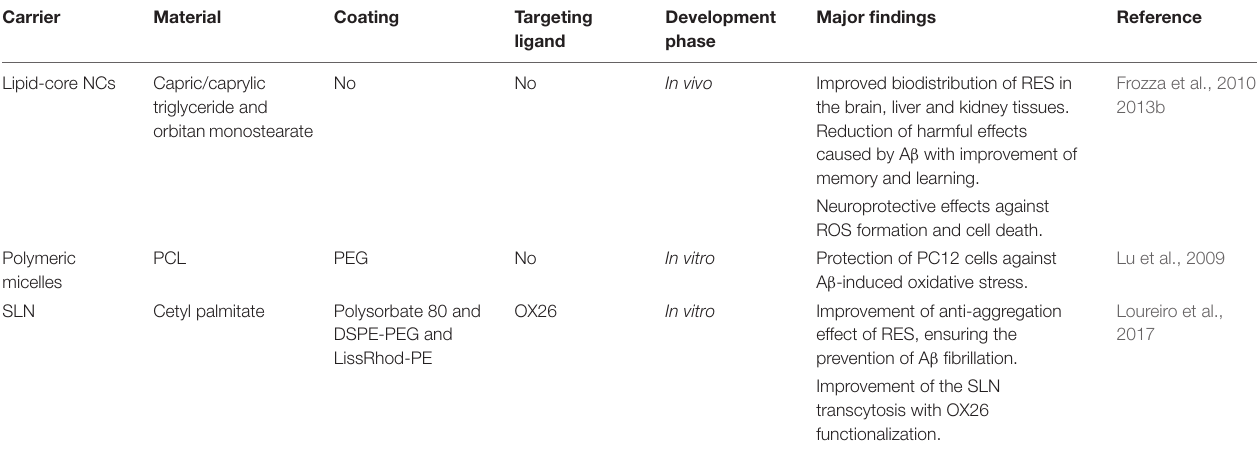
TABLE 1 | Currently developed DDS for RES delivery for AD’s